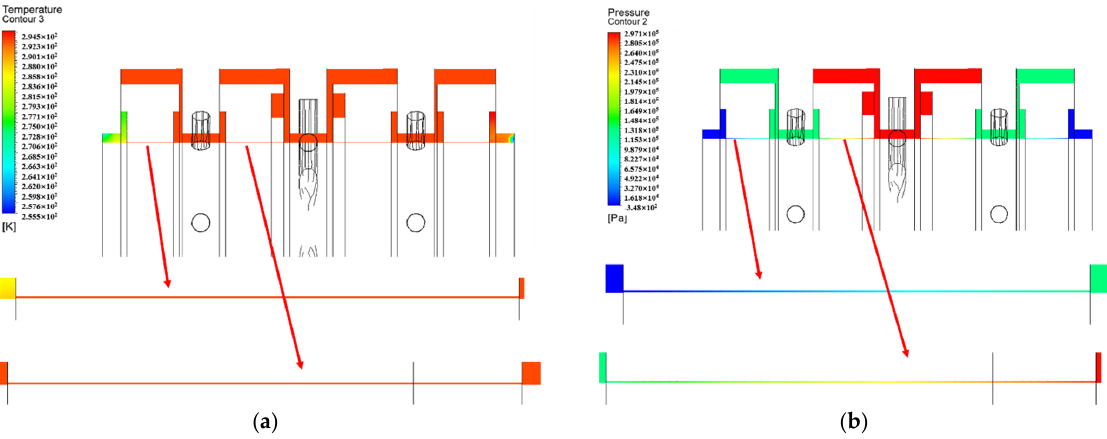
Figure 10. Finite-element analysis contour. ( a ) Temperature-field contour; ( b ) pressure-field contour.